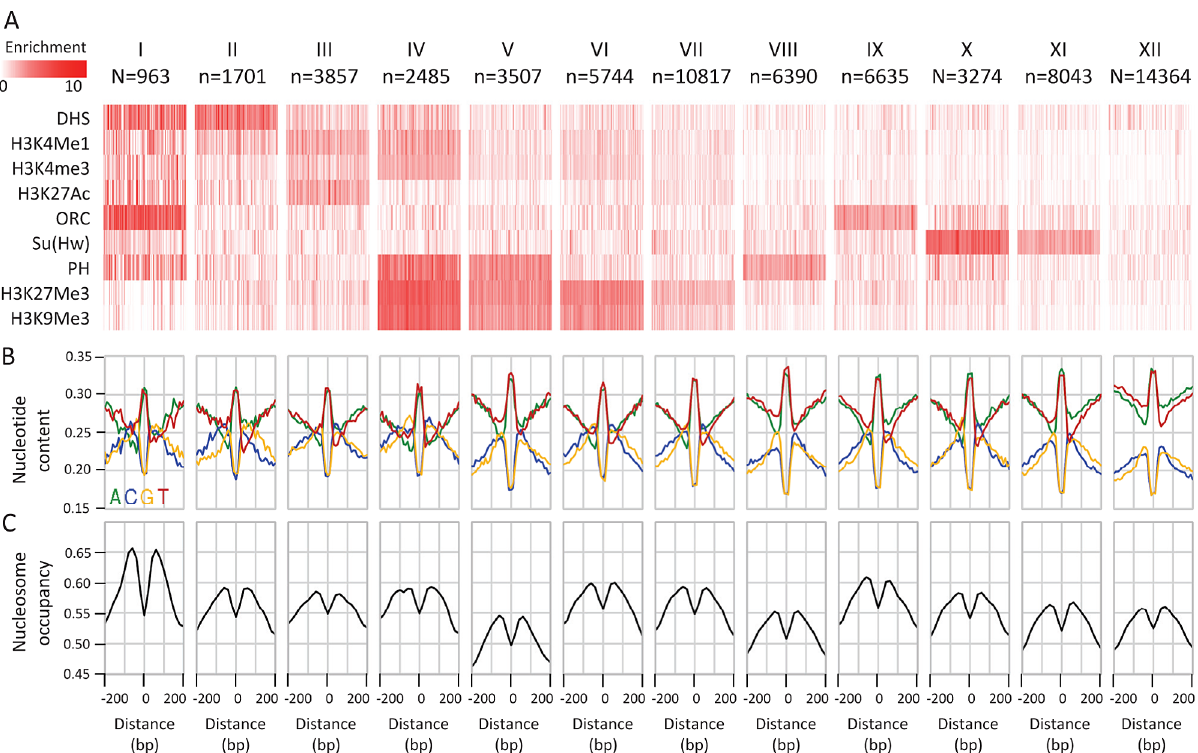
Figure 2. Epigenetic clustering of conserved elements. A) Classifying CEs according to their epigenetic context. Average enrichments (color coded, white-low, red-high) of selected epigenetic marks (rows) within CEs (columns) are depicted for groups of CEs clustered according to their epigenomic profiles. Due to size limitations, only 100 randomly chosen CEs are shown for each group. B) Average nucleotide compositions around CE clusters. While the basal GC content is variable between the epigenomic clusters, the punctuated GC elevation near conserved elements is pronounced in all of them. C) Nucleosome enrichment around CEs. Average nucleosome occupancy percentile (y-axis) around the CE centers is depicted for each cluster. A consistent depletion in occupancy over the CE center is observed for MNase-seq data of Weber et al. [69] in S2